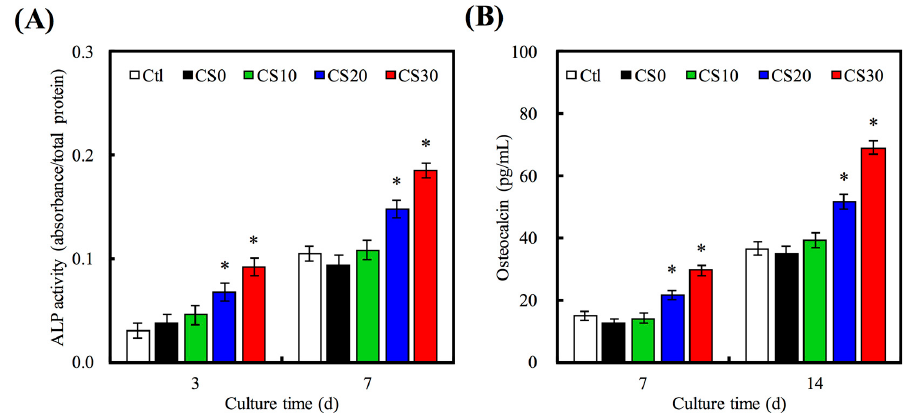
Figure 10. ( A ) ALP activity; and ( B ) OC amount of hMSCs cultured on various scaffolds for different time points. “*” indicates a significant difference ( p < 0.05) compared to CS0.